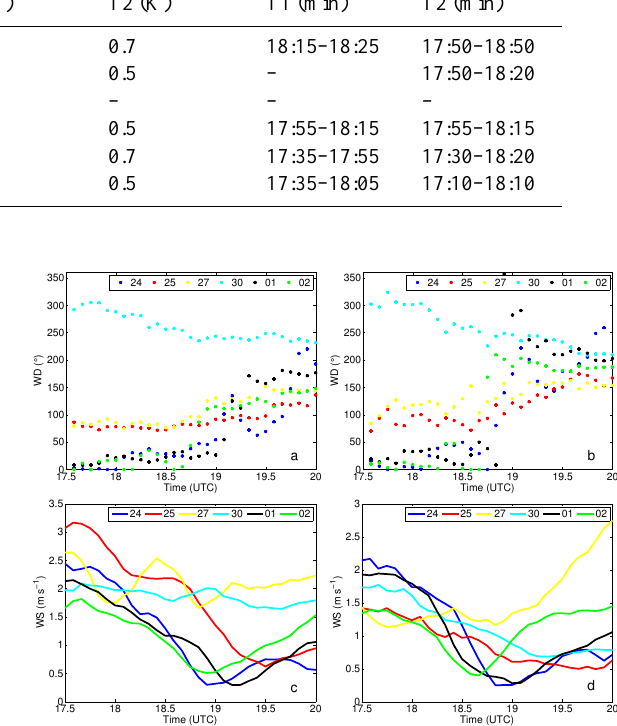
Table 1. Characteristics of the LTM at T1 and T2 for all the studied IOPs. IOP